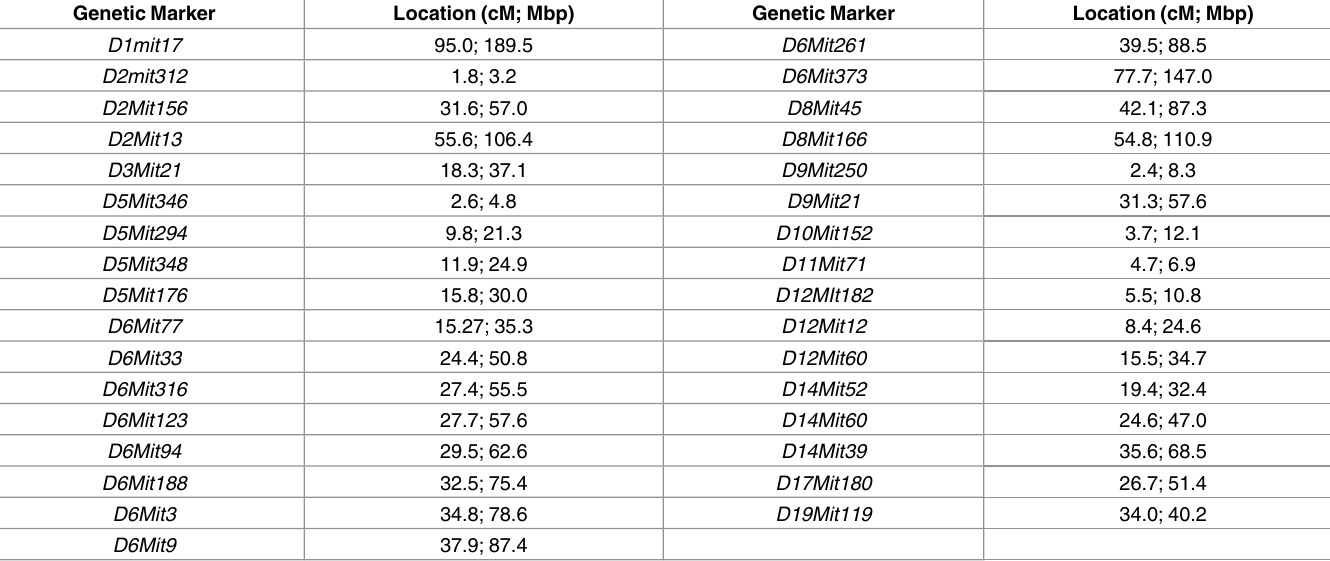
Table 1. Marker used for markerassisted backcrossing of B6.129Sv- Rint1tm1WHL mice 1 . Genetic